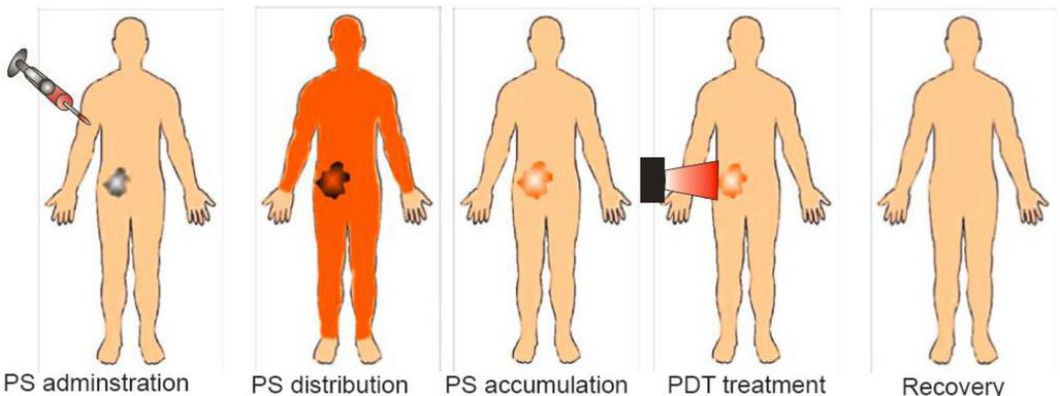
Figure 30. Schematic showing photodynamic therapy (PDT) by injecting a photosensitizer (PS) into human body. PS is then distributed and accumulated in tumor tissues. This is followed by ultraviolet light irradiation to generate ROS for killing cancer cells. Reproduced from [171] under the Creative Commons Attribution license.